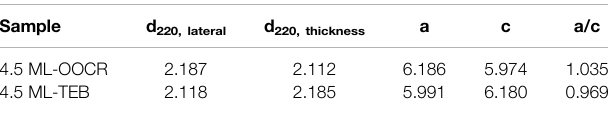
TABLE 2 | The lattice parameter information of NPLs for (220) (Å)